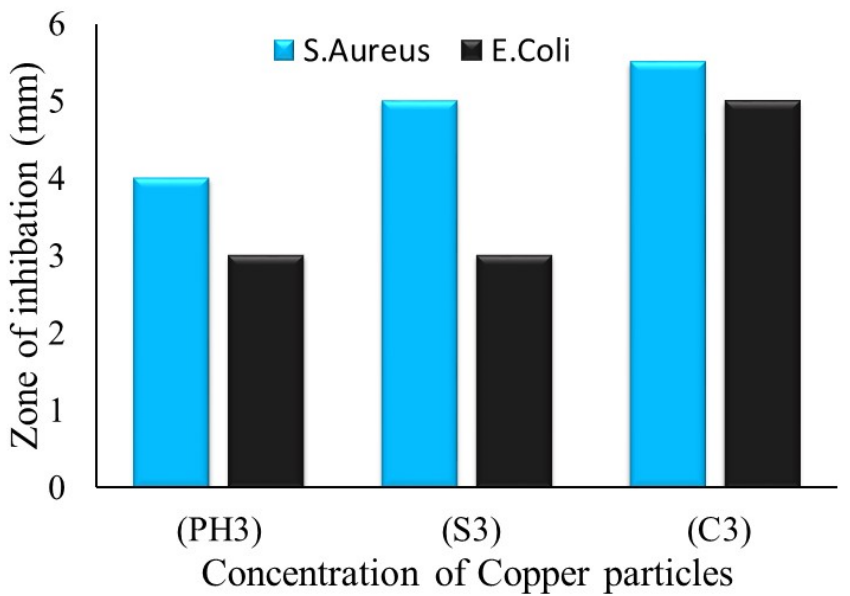
Figure 17. Antibacterial activity of coated fabrics after washing.